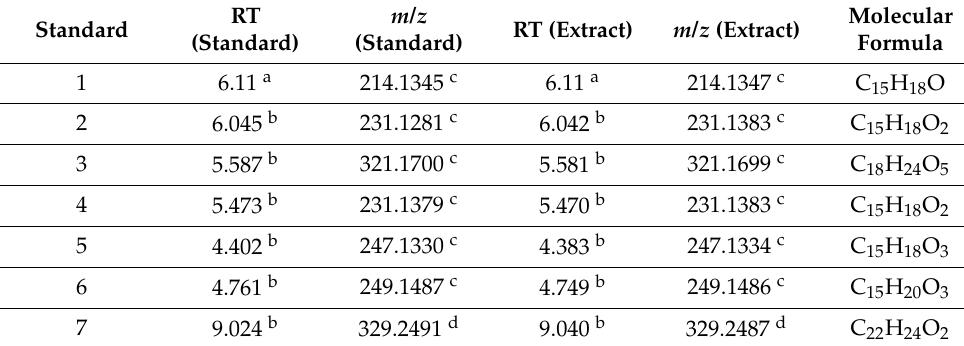
Table 3. Summary of LC-/GC-MS characteristics of plant compounds identified in myrrh extract. Retention times (RT in min) and mass spectra ( m / z ) for furanoeudesma-1,3-diene (1), curzerenone